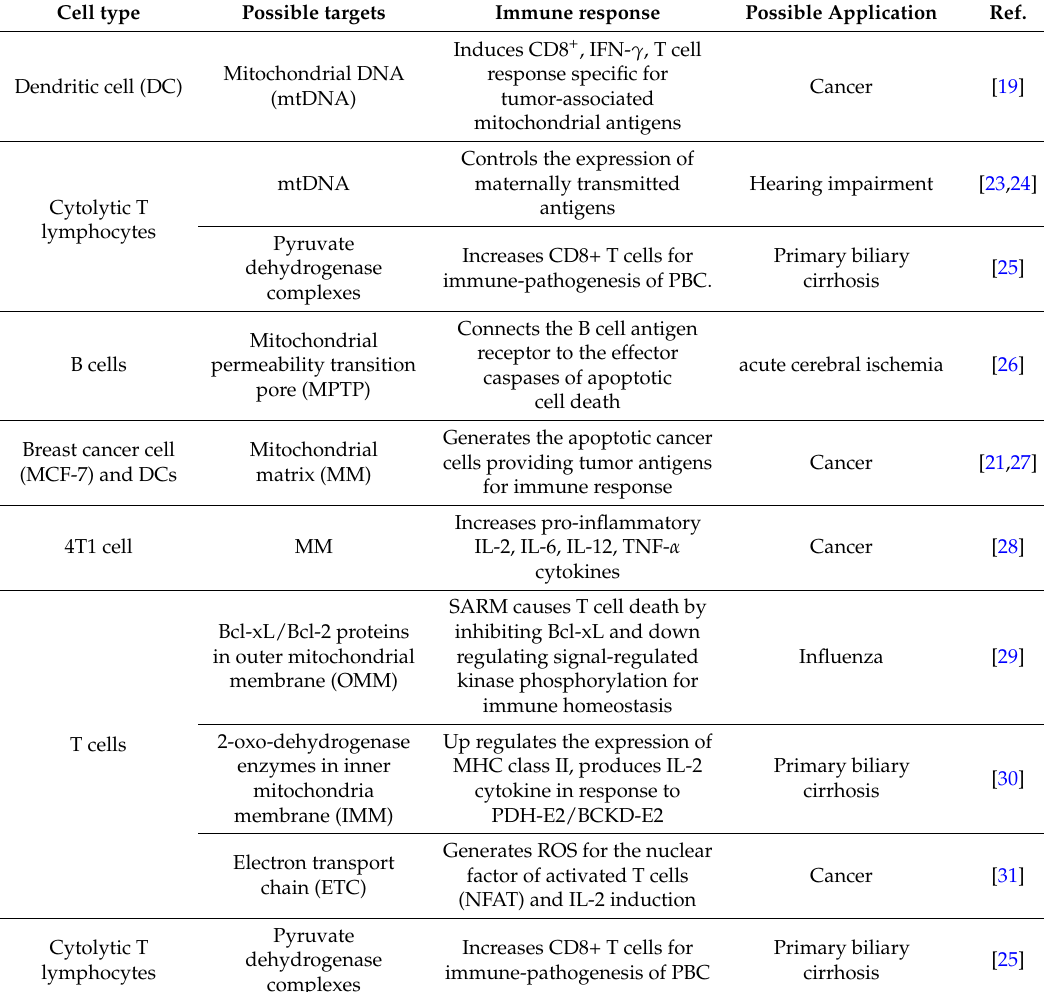
Table 1. Summary of possible mitochondrial targets for vaccine